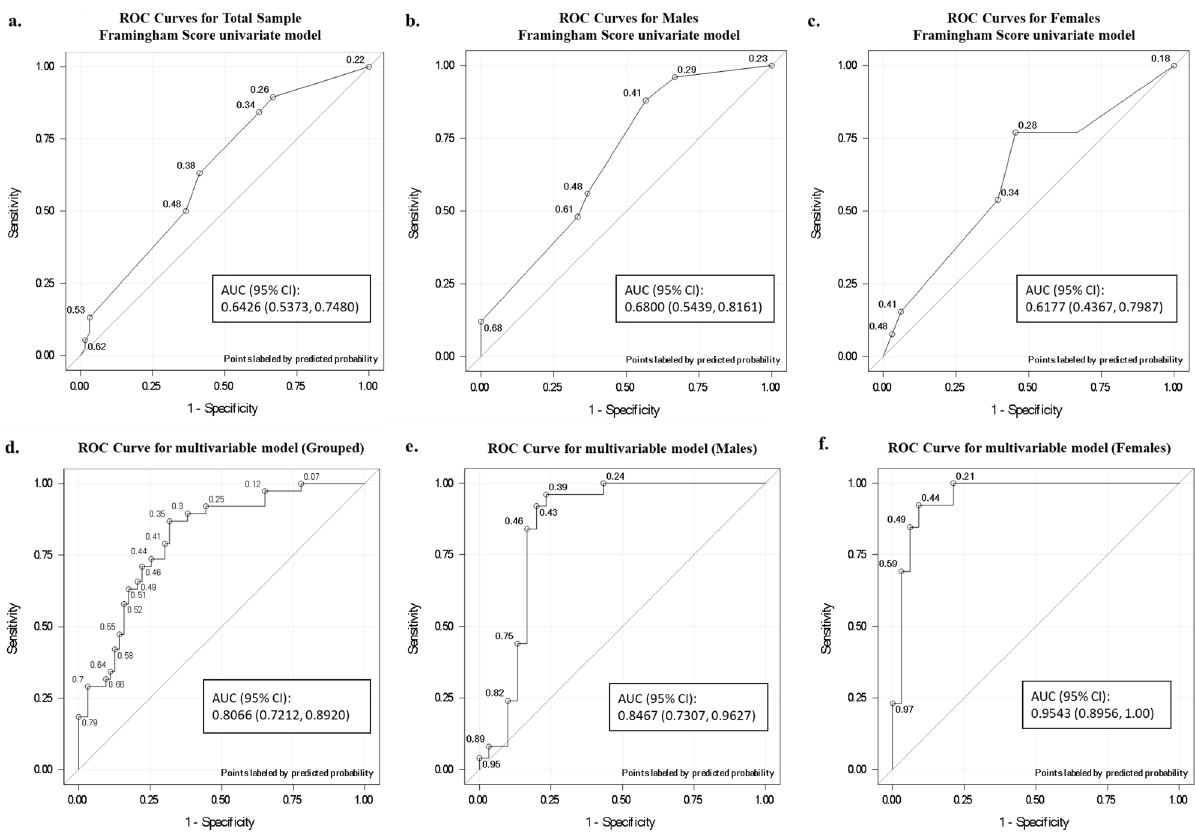
Figure 1. Comparison of ROC area under curve of Framingham scores ( a – c ) and our biomarker optimized models ( d – f ) to discriminate between presence and absence of subclinical atherosclerosis. Framingham scores predictive capability in the grouped analysis ( a ), in males ( b ) and females ( c ) showed better discriminative ability in males than females for subclinical atherosclerosis. The biomarker optimized models in the grouped analysis ( d ), in males ( e ) and females ( f ) consistently demonstrated improved predictive capability. CI, Confidence interval; AUC, area under